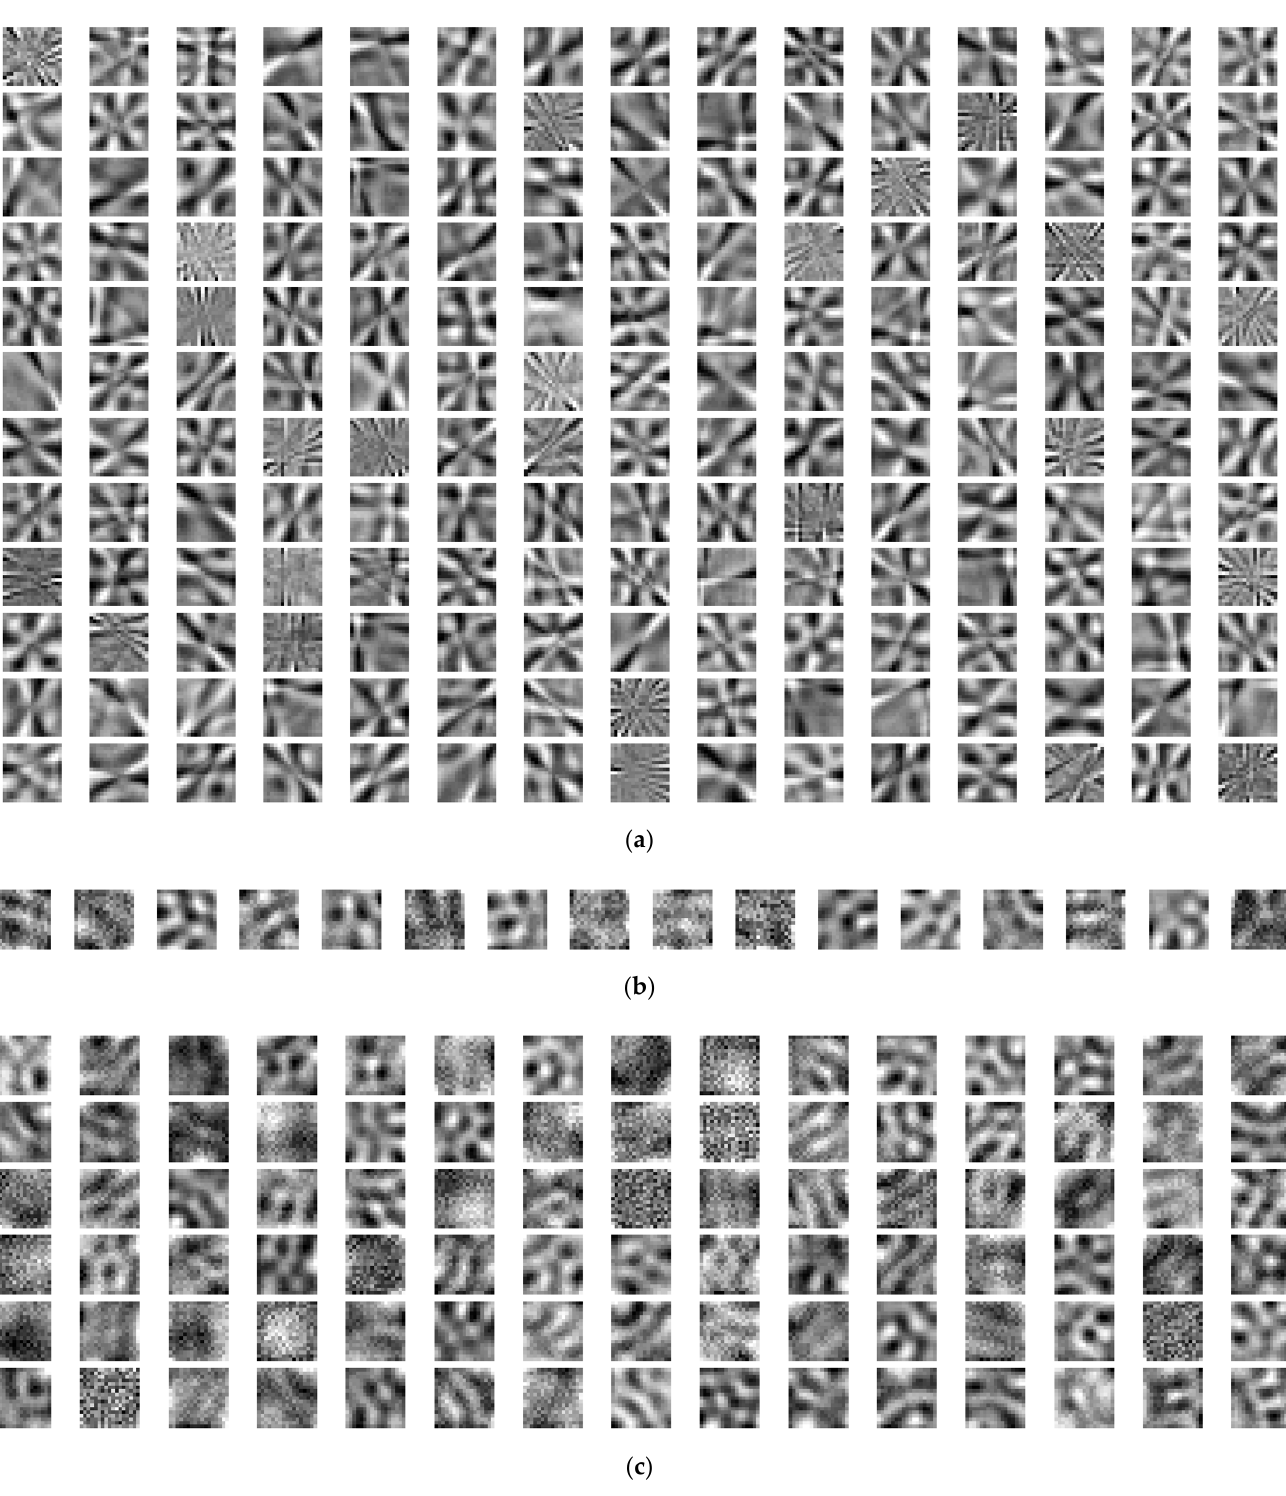
Figure 10. Filters from the only convolutional layer of the best shallow CNN, SN1-SELU (( a ), 180 filters), from the first convolutional layer of the best deep CNN, DN2-TanH (( b ), 16 filters) and from the first convolutional layer of the deep CNN, DN4-SS (( c ), 90 filters). The filters are shown for one training instance.